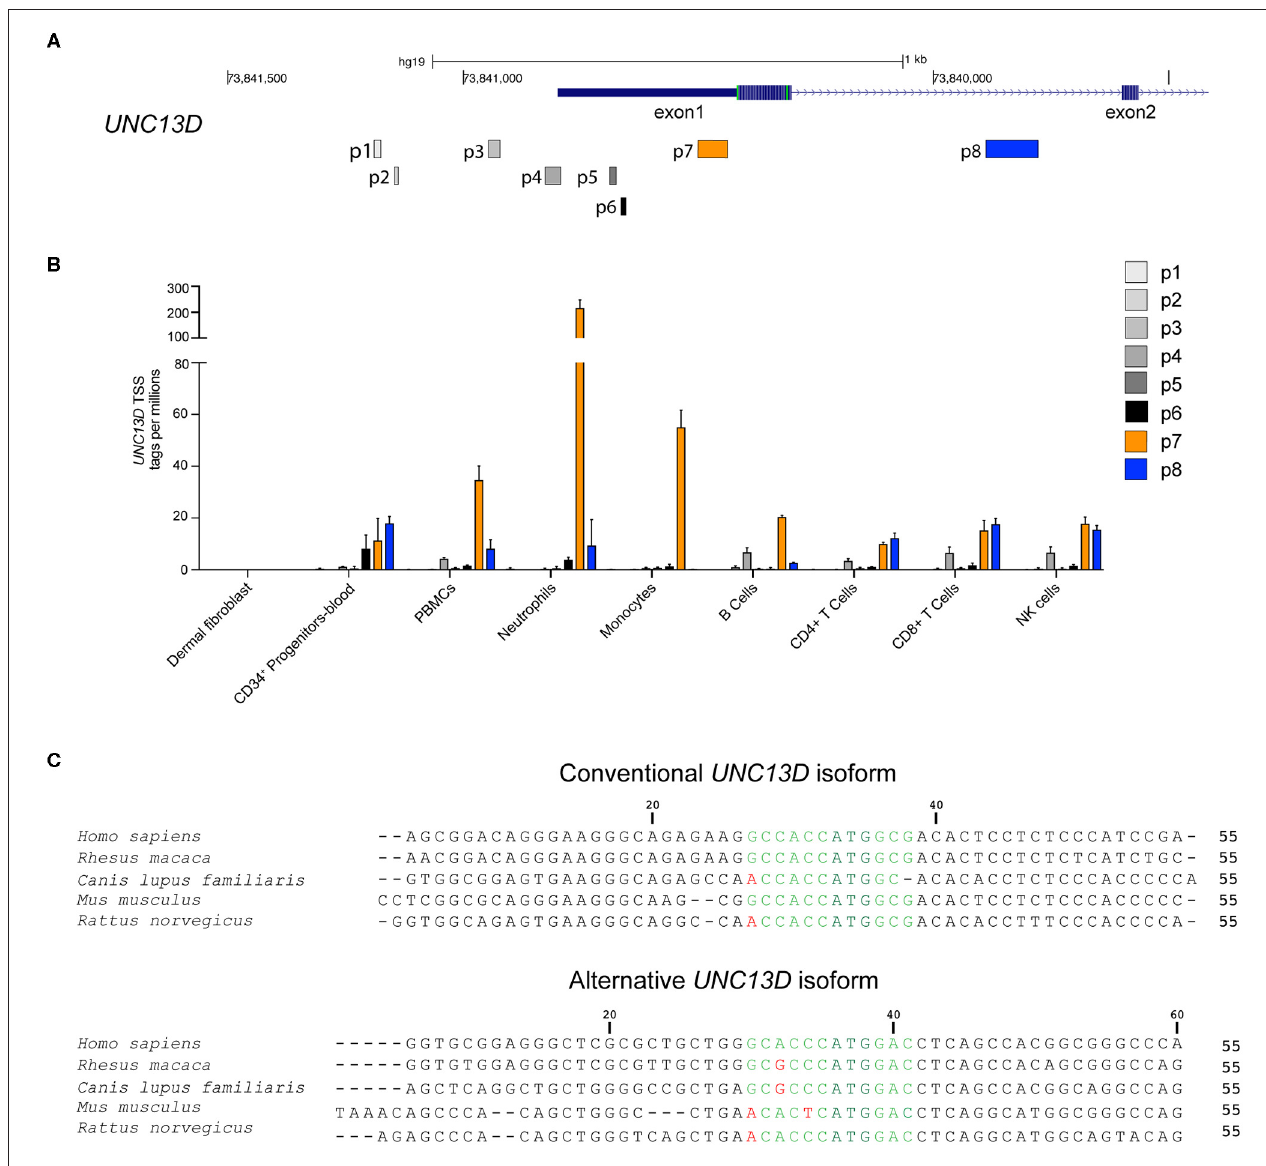
FIGURE 1 | Transcription and Kozak sequence conservation of conventional and alternative UNC13D transcripts. (A) Localization of UNC13D TSS on human chromosome 17 according to FANTOM5 cap analysis gene expression. p7 and p8 represent the conventional and alternative UNC13D TSSs. (B) The histogram depicts transcription of different UNC13D TSS from the FANTOM5 CAGE data of primary fibroblasts as well as total and sorted peripheral blood subsets. (C) Alignment of conventional and alternative UNC13D Kozak sequences from different mammalian species. The Kozak sequences includes bases flanking the ATG start codon at positions − 6/ + 5. The ATG start codon is colored dark green, conserved and non-conserved residues are in light green and red, respectively.